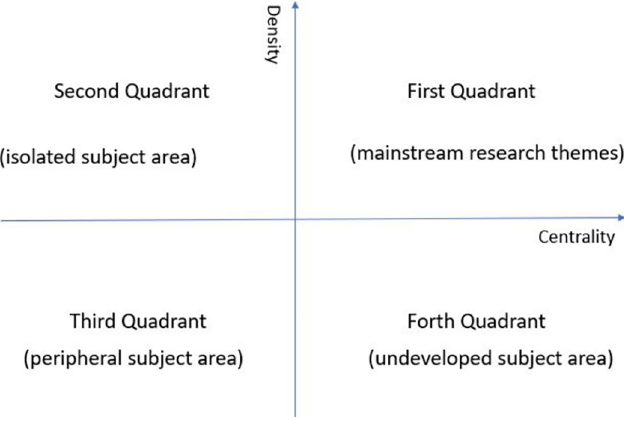
Fig 1. The brief description of four quadrants in strategic